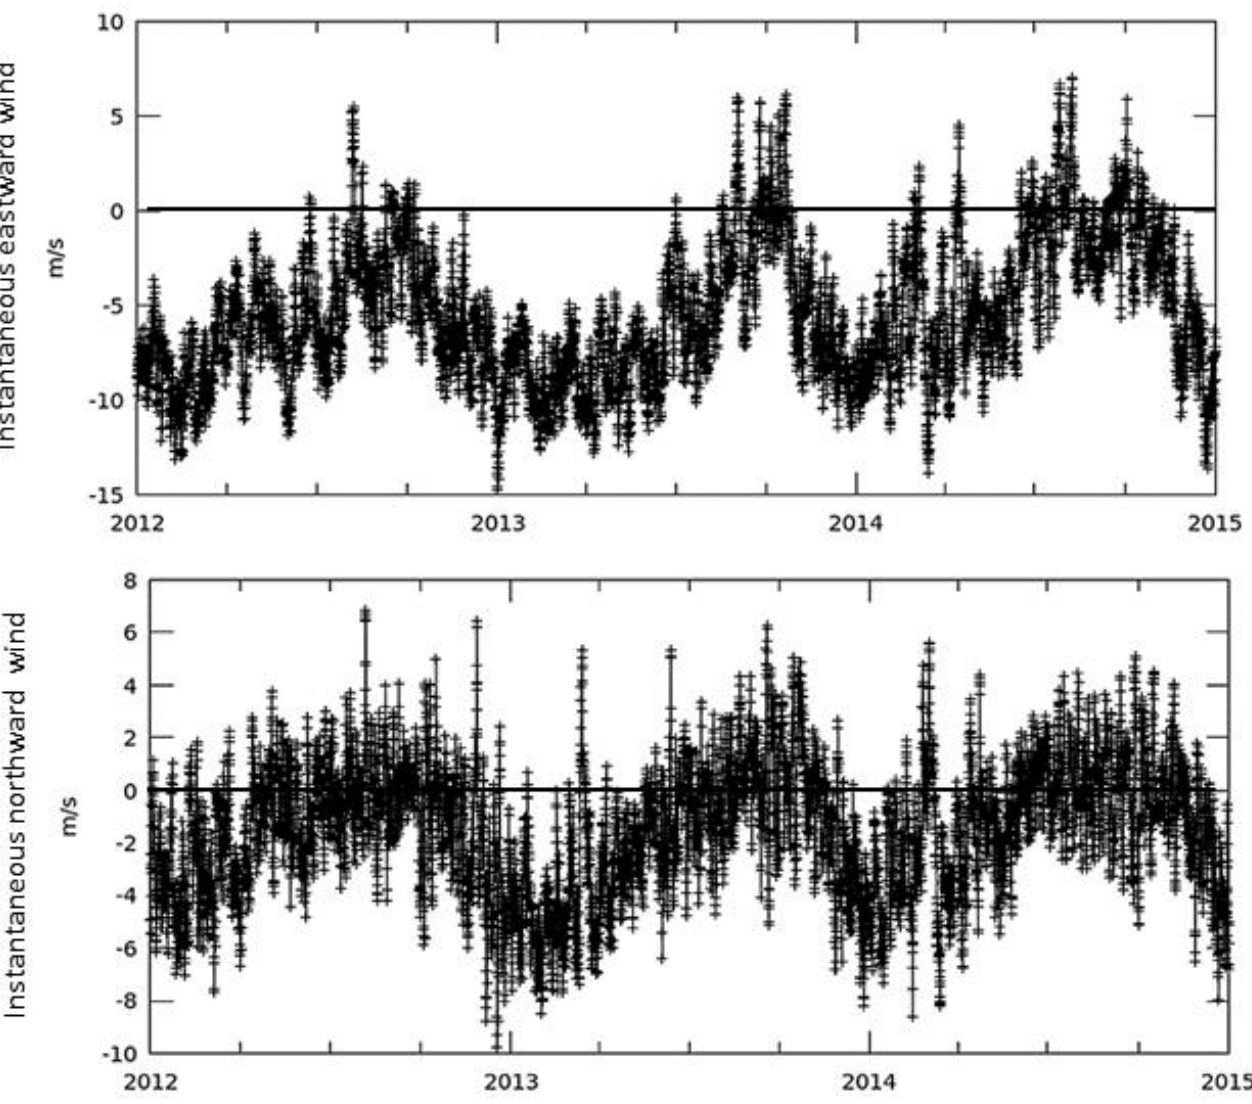
Figure 7. ( top ) MERRA-2 instantaneous eastward wind and ( bottom ) instantaneous northward wind for the Chuuk Lagoon region, at the 950 hPA pressure layer, 3-hourly temporal resolution, for the period January 2012 – December 2015. The region used for these figures was 149 – 154.2 E, 6.0 – 8.0